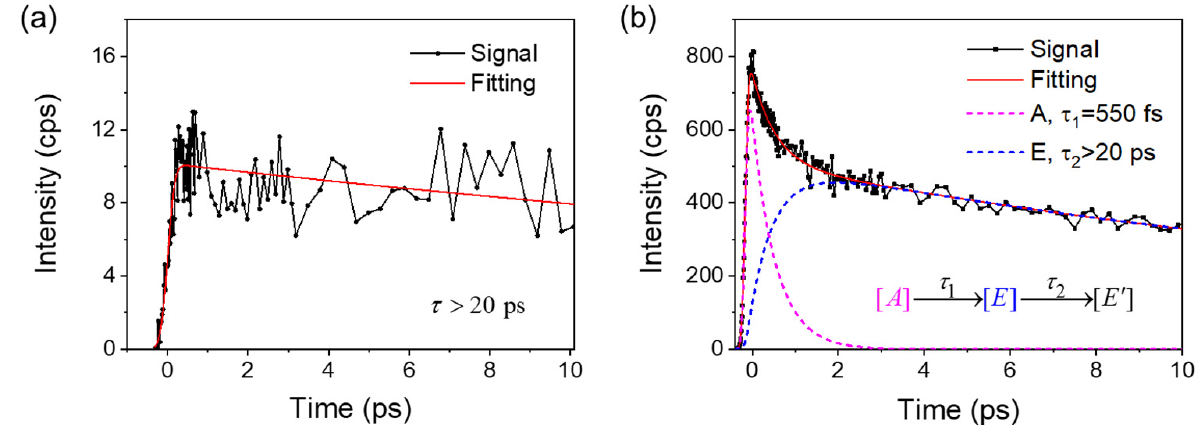
Figure 7. Femtosecond fluorescence up-conversion decay profiles of ( a ) Al 2 O 3 :OHCCA free and ( b )